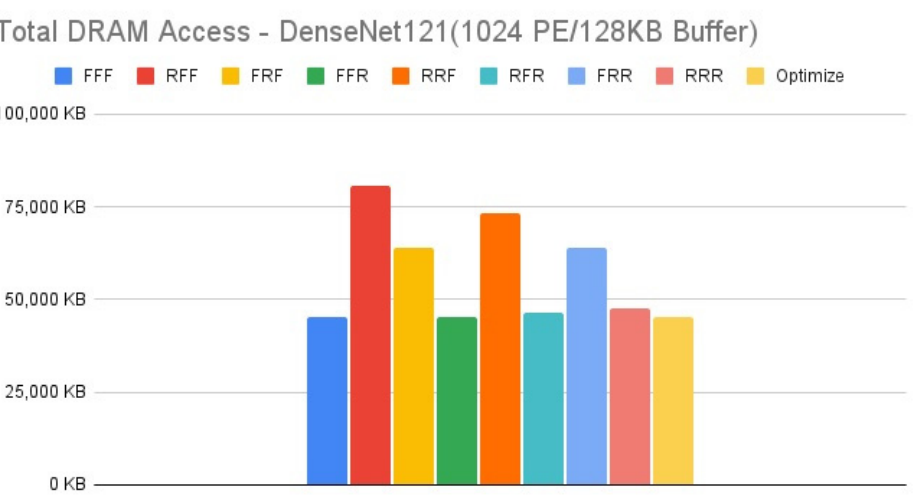
Figure 19. Average PE utilization—HarDNet39 (256 PE/128 KB Buffer).